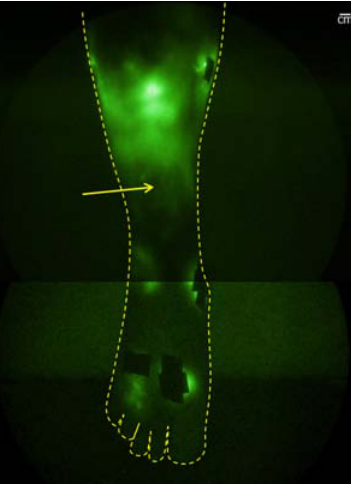
Note : Image shown is montage of smaller regional images. Scale bar ¼ 1cm. Fig. 4. NIRFLI image of subject 1's lower right anterior leg, after PCT treatment. Extravascular/di®use, as well as primary vessel vascular/linear (small vessels noted by arrow) dye/lymph is visible. Injection sites are covered by small round bandages or small rectangles of black tape to prevent camera